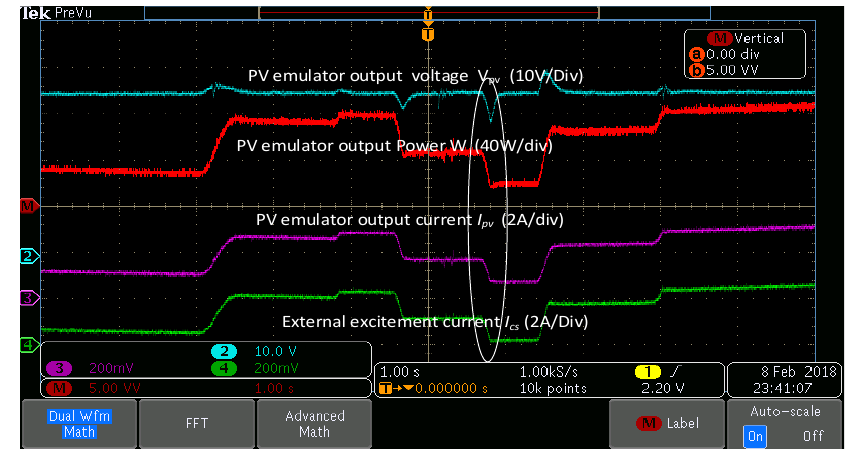
Figure 15. Conventional P&O (fixed step size) MPPT Test results with variable current source currents (emulating the variable photo-generated current).